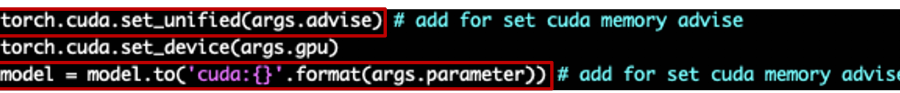
Figure 5. Modified PyTorch code to apply CUDA Unified Memory